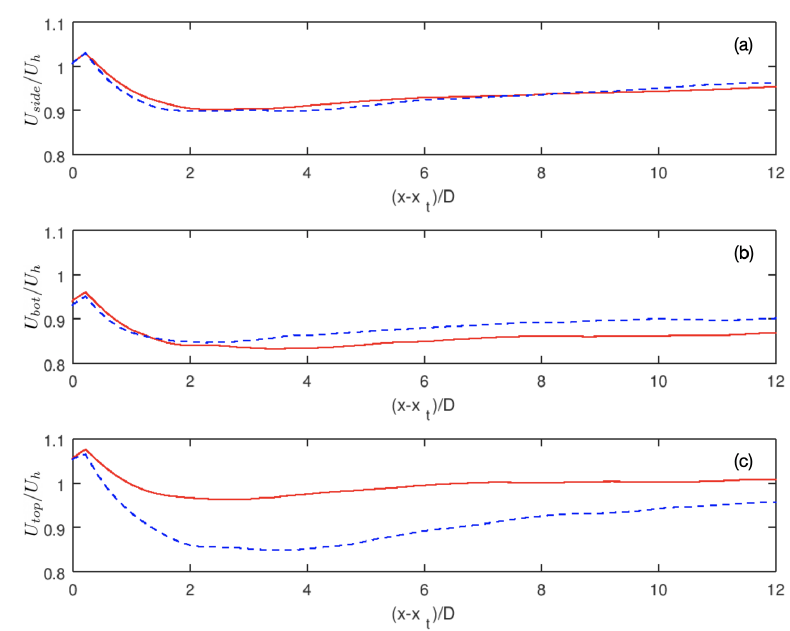
Figure 12. The averaged downwind velocity on the surface of the control volume for ( a ) on the two side surface of the control volume (Equation (16)), ( b ) on the bottom surface of the control volume Equation (17) and ( c ) on the top surface of the control volume Equation (18).